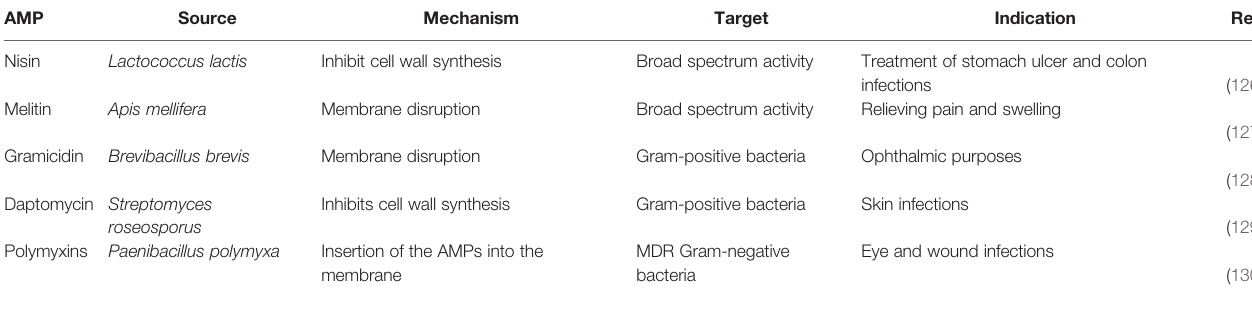
TABLE 3 | Natural AMPs approved by the US FDA for clinical